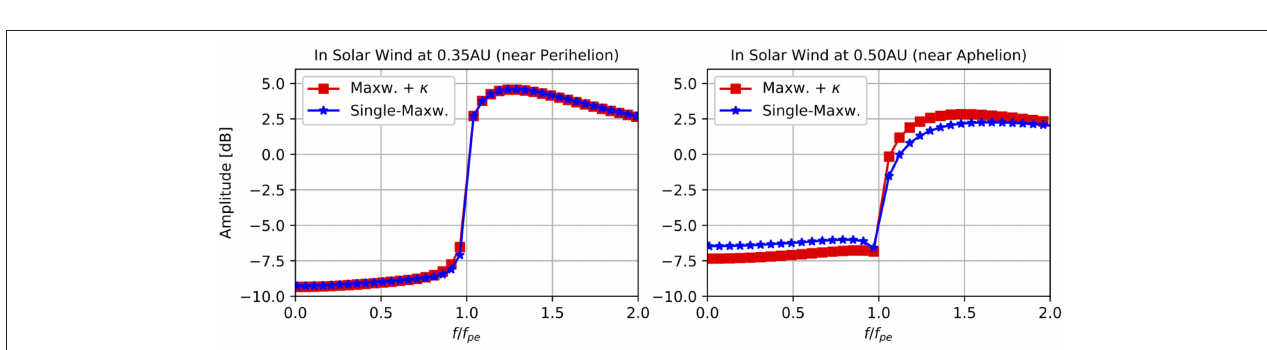
FIGURE 9 | Modeled PWI/AM 2 P mutual impedance spectra for (i) a core Maxwellian evdf and a halo kappa evdf (red squared line) and (ii) only the core Maxwellian evdf (blue asterisk line) in the in-situ measured solar wind plasma at 0.35 AU (near Mercury perihelion, left panel) and 0.5 AU (near Mercury aphelion, right panel). The amplitude is expressed in 20 log 10 and the frequency is normalized by the total electron plasma frequency.